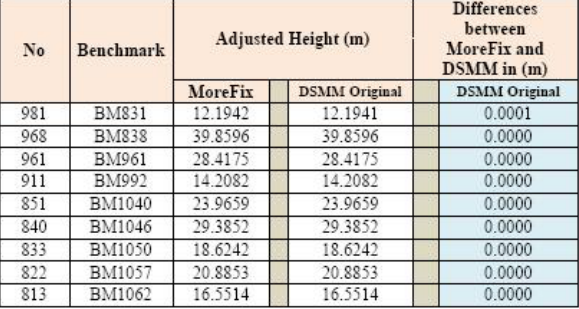
Table 3: The results of BMs height computed by MoreFix